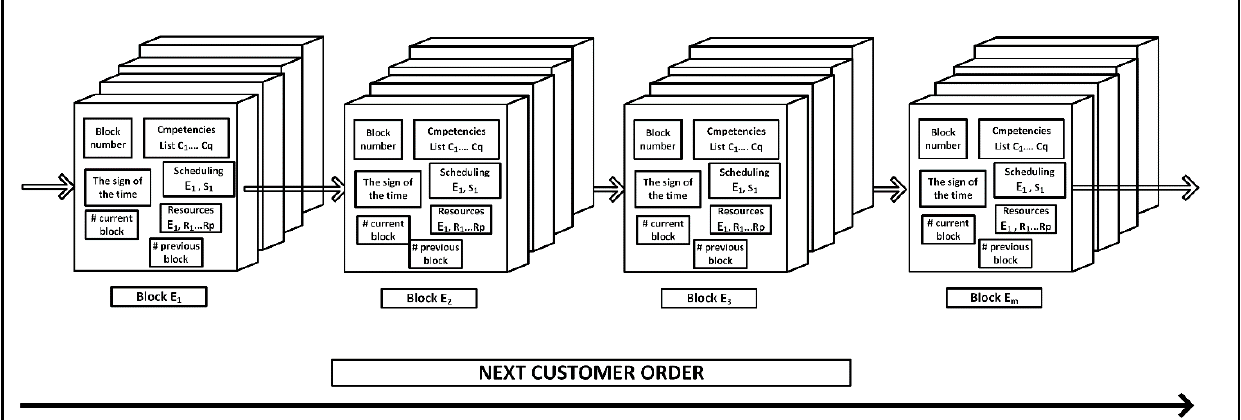
Figure 7. Blockchain for reacting to subsequent orders for employees and building consensus. # marks the beginning of a comment that continues to the end of the physical line. # precedes the reference to the previous and the next block so that the new data that is applied will look up the order of the data and can bind them together in a blockchain.